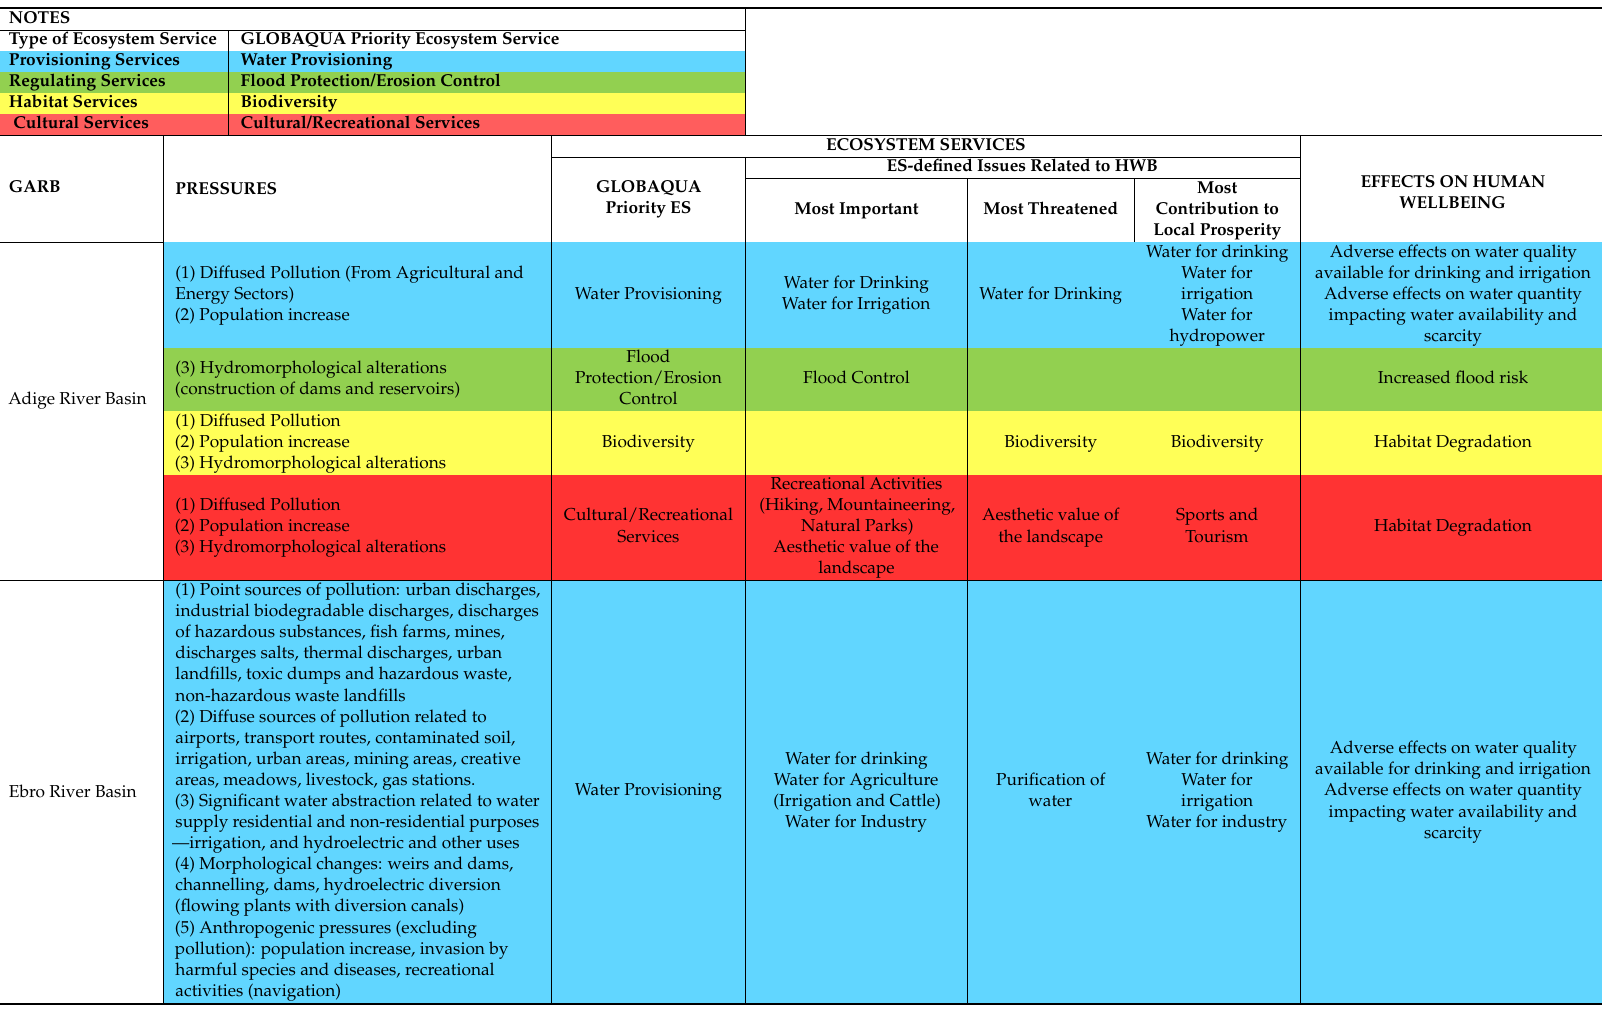
Table 1. Linking Pressures to Human Wellbeing: an analysis of the effects of pressures at the GARB level using an ecosystem services framework (developed